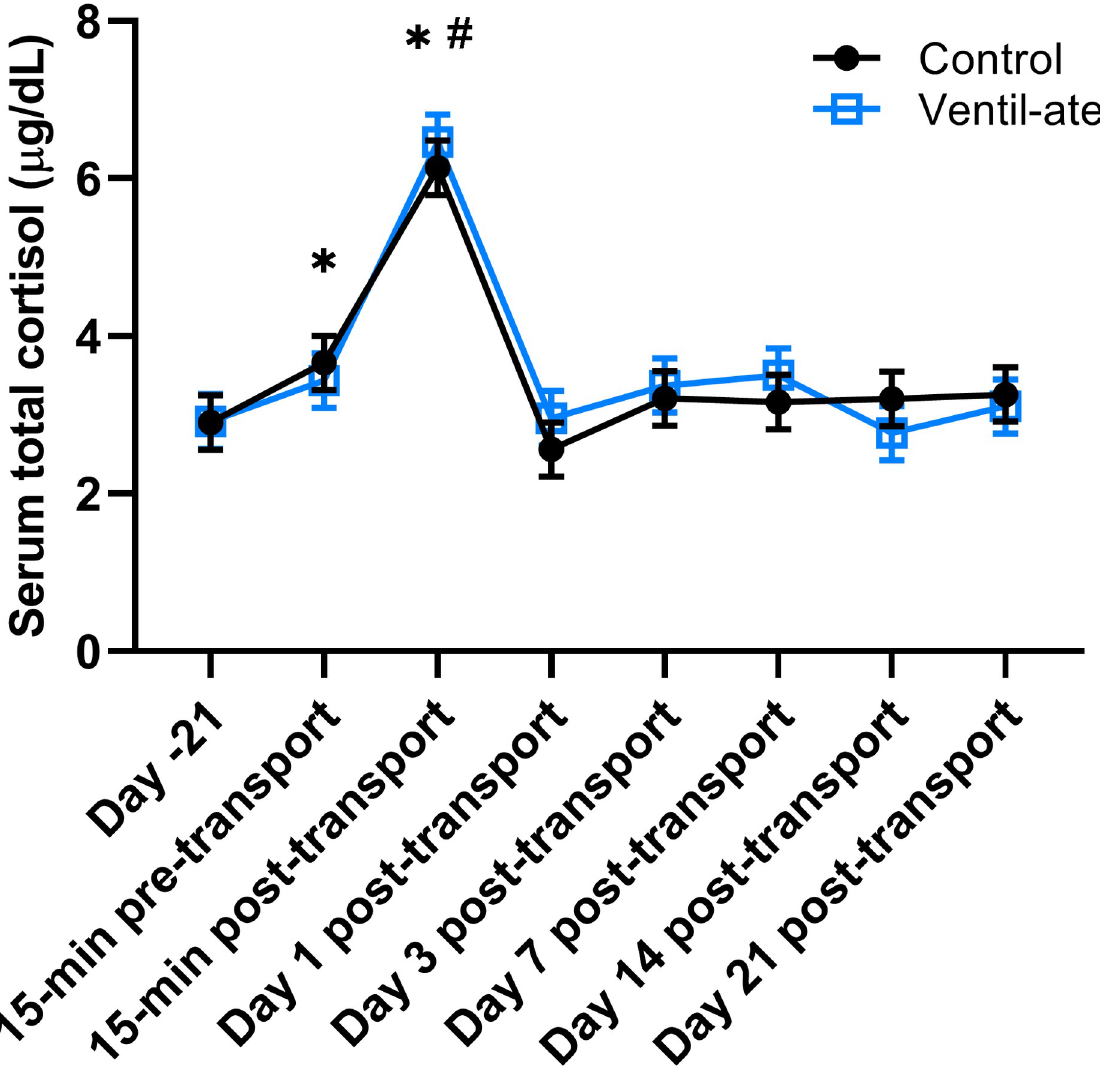
Fig 2. Serum total cortisol concentration. For illustrative purposes, the figure reflects the results (least squares means ± SE) from the analysis that included the group-by-time interaction; however, the significant time differences noted on the figure reflect the results of the analysis with only group and time included as main effects. No significant group ( P = 0.8804) or group-by-time ( P = 0.7053) effects were observed, but there was a significant time effect ( P < 0.0001). � denotes a significant difference ( P < 0.05) from baseline (Day –21). # denotes a significant difference ( P < 0.0001) from all other time